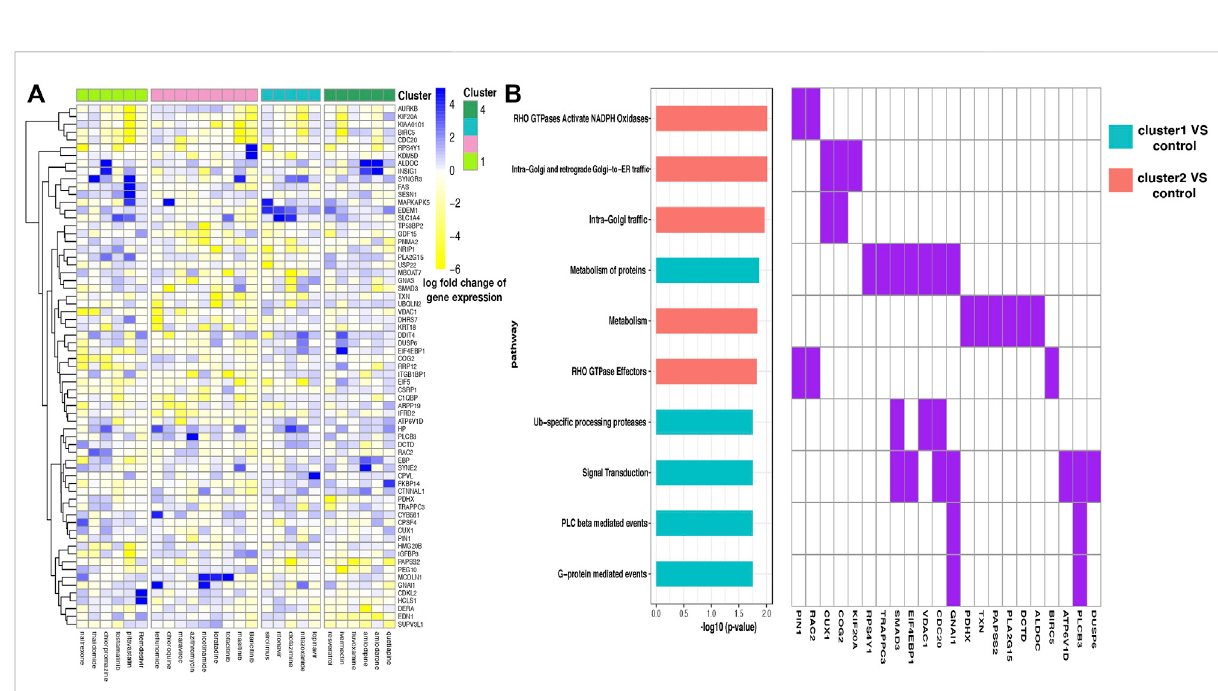
FIGURE 4 (A) Heatmapofthelogfoldchangeofgeneexpressionlevelsfordrugsinfourclusters.Eachrowisagene,andeachcolumnisadrug.Drugsare ordered according to their cluster index number. (B) Enriched pathways in two discriminant gene sets corresponding to two pairs of drug clusters — drugcluster1 – controlpairand2 – controlpair.Enrichmentanalysiswasperformedintwodiscriminantgenesetsseparately,wherethetwo gene sets contain genes showing distinguishing expression patterns between drug cluster 1 and the control group and drug cluster 2 and the control group separately, and the control group was de fi ned as the combination of drug cluster 3 and 4. Ten pathways with the most signi fi